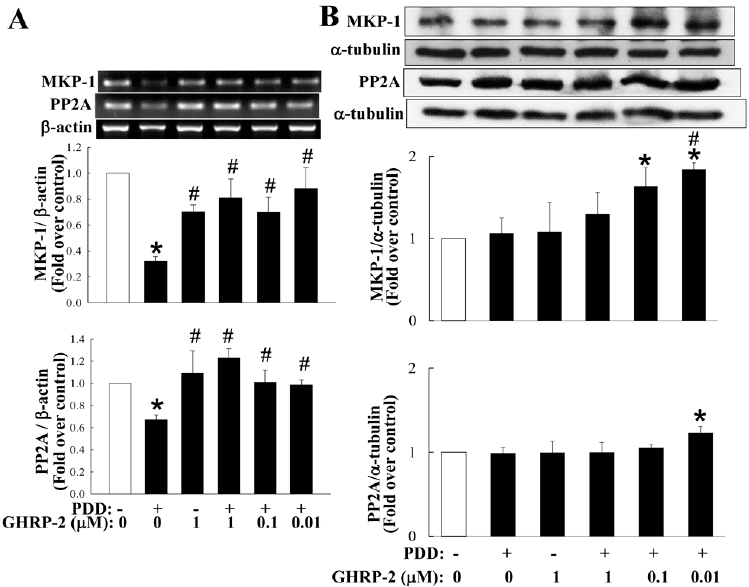
Figure 9. Regulation of mitogen-activated protein kinase phosphatase-1 (MKP-1) and protein phosphatase 2A (PP2A) expression by PDD and GHRP-2. Plated KGN cells were pretreated with GHRP-2 (0.01, 0.1, 1 µM) for 2 h, and PDD (100 nM) was included for an additional 12 h. The MKP-1 and PP2A mRNA or protein expression levels were determined by RT-PCR ( A ) and Western blotting